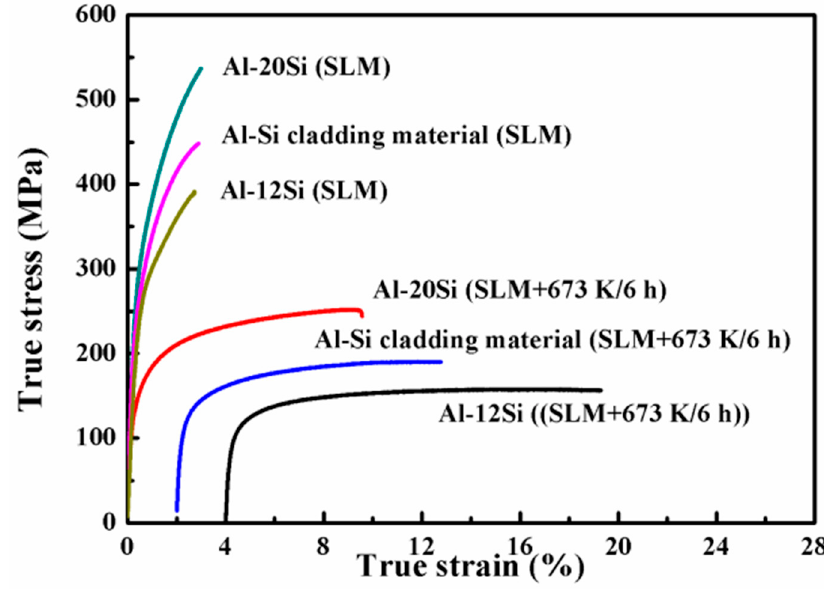
Figure 5. True stress–strain curves of Al–Si alloys and Al–(12-20)Si bi-materials.